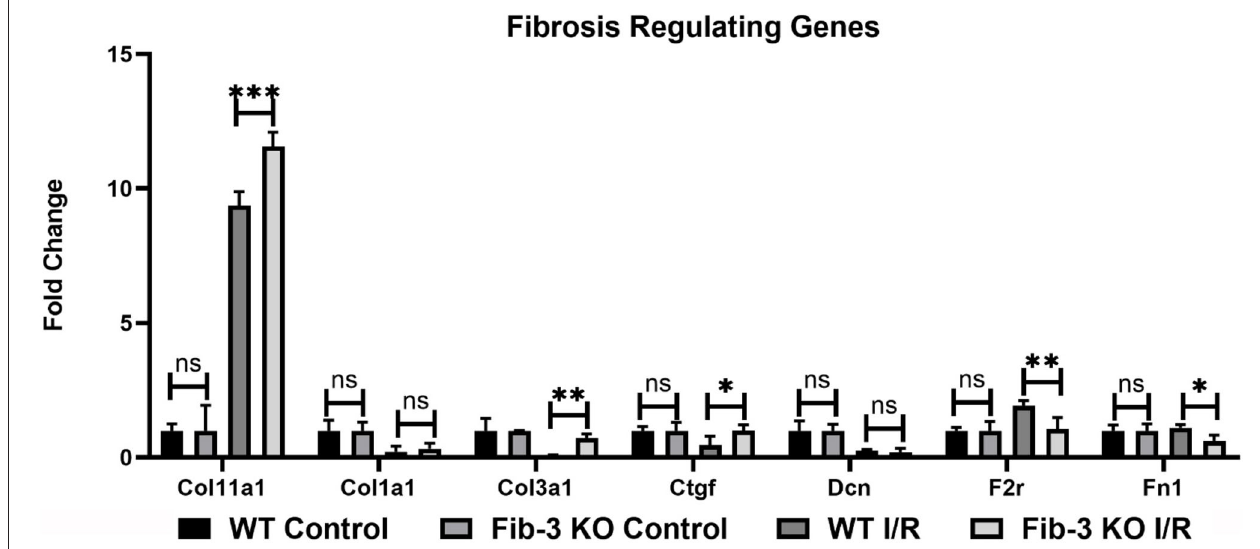
FIGURE 10 | Changes in fibrotic genes in WT and Fib-3 KO CSs following I/R injury. Relative expression of Col11a1, Col1a1, Col3a1, Ctgf, Dcn, F2r and Fn1 in WT and Fib-3 KO CSs. Two-way ANOVA with Sidak’s multiple comparison test, p > 0.05 = ns, p < 0.05 = *, p < 0.01 = ** and p < 0.001 = ***. Error bars represent the mean ± SD ( n =